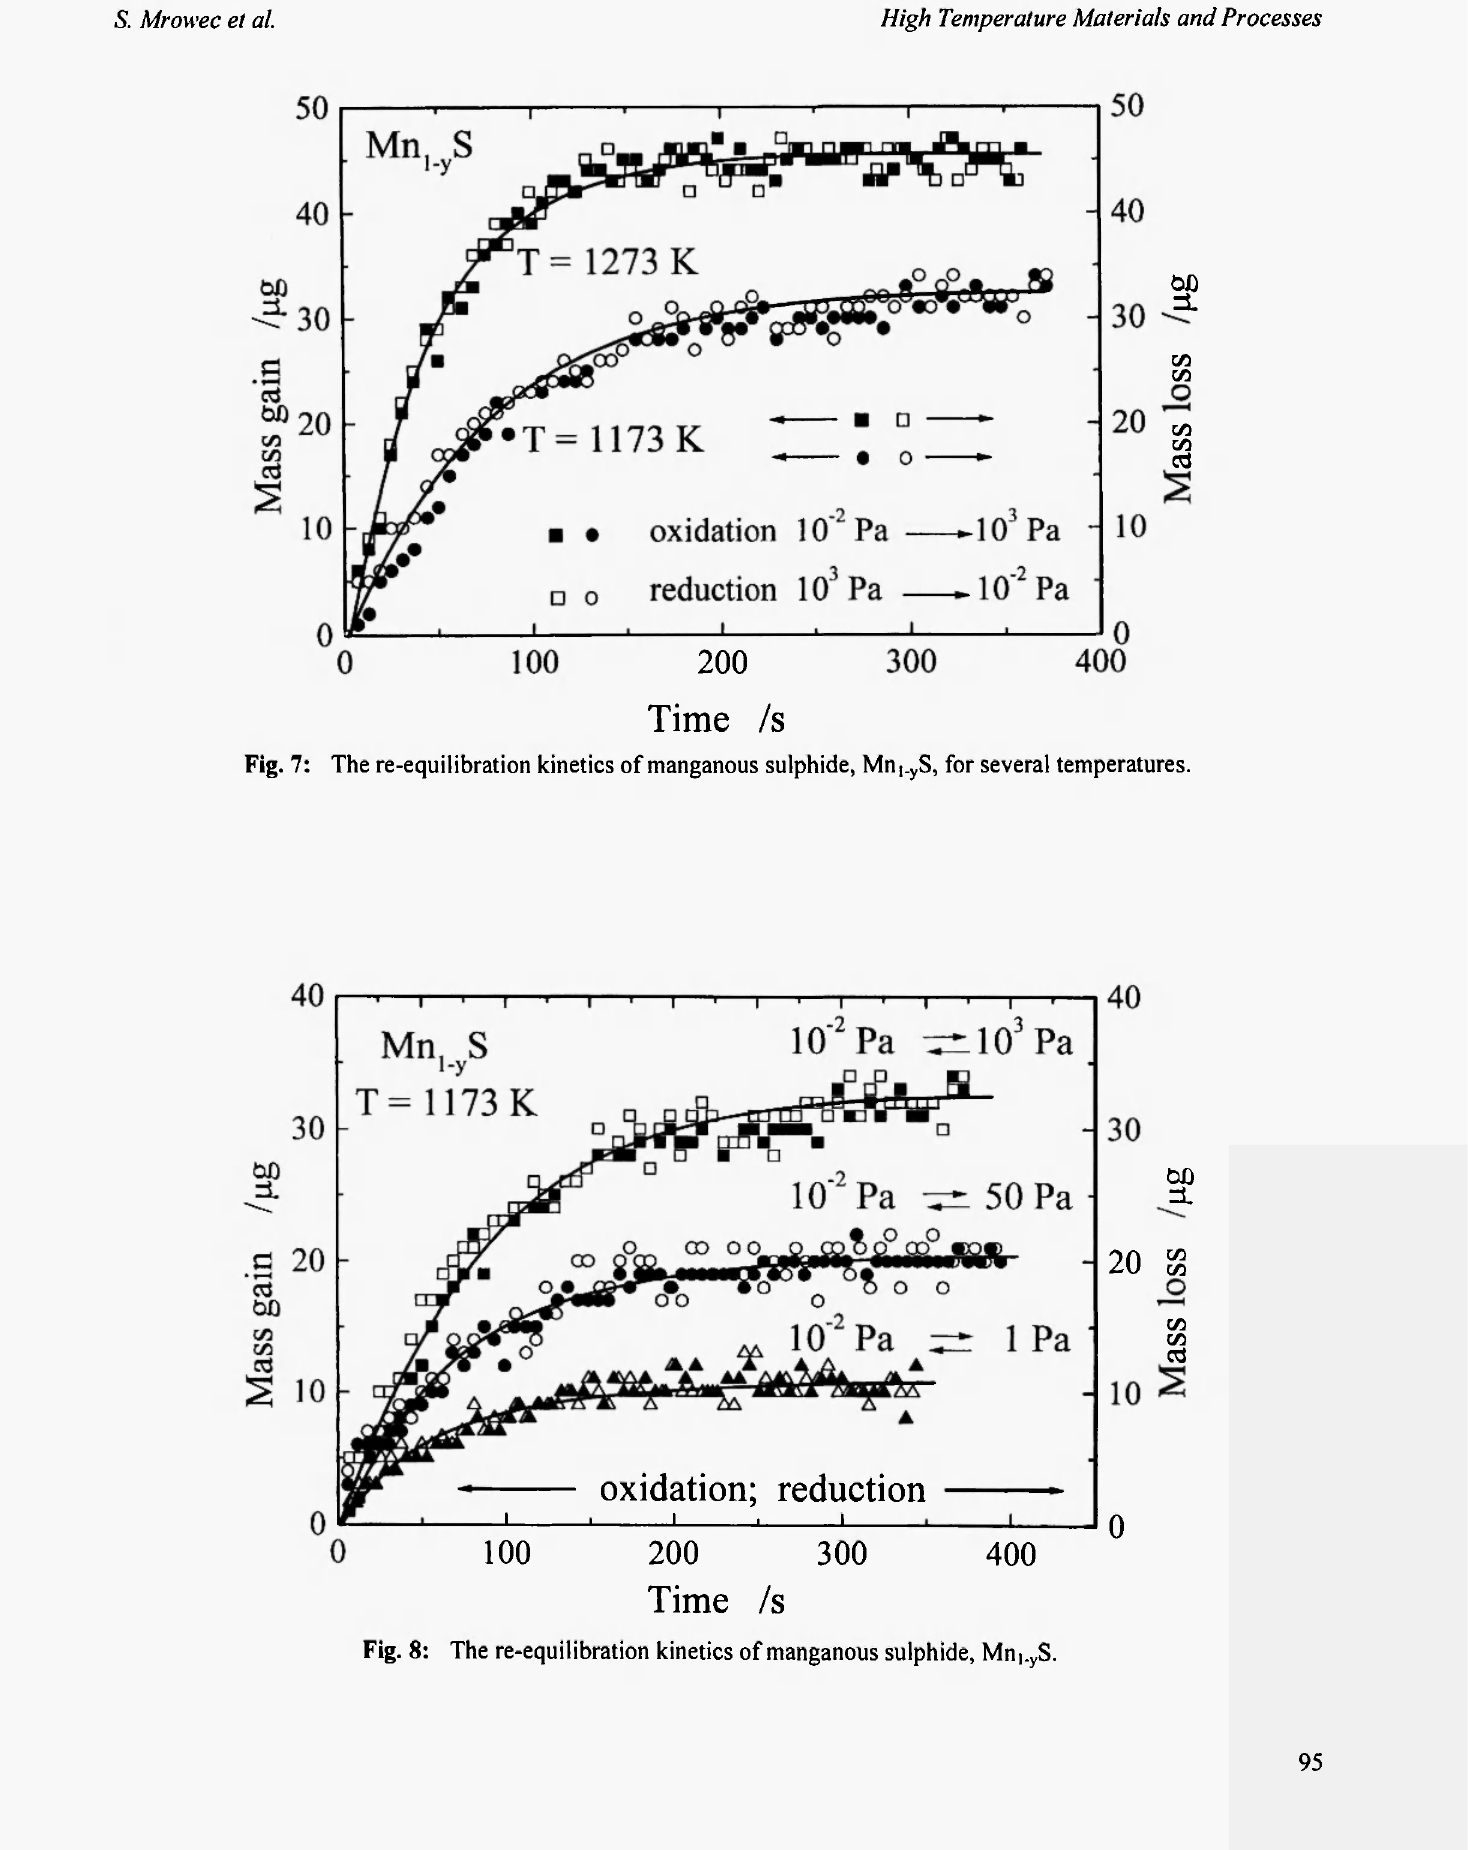
Fig. 8: The re-equilibration kinetics of manganous sulphide, Mn,. y